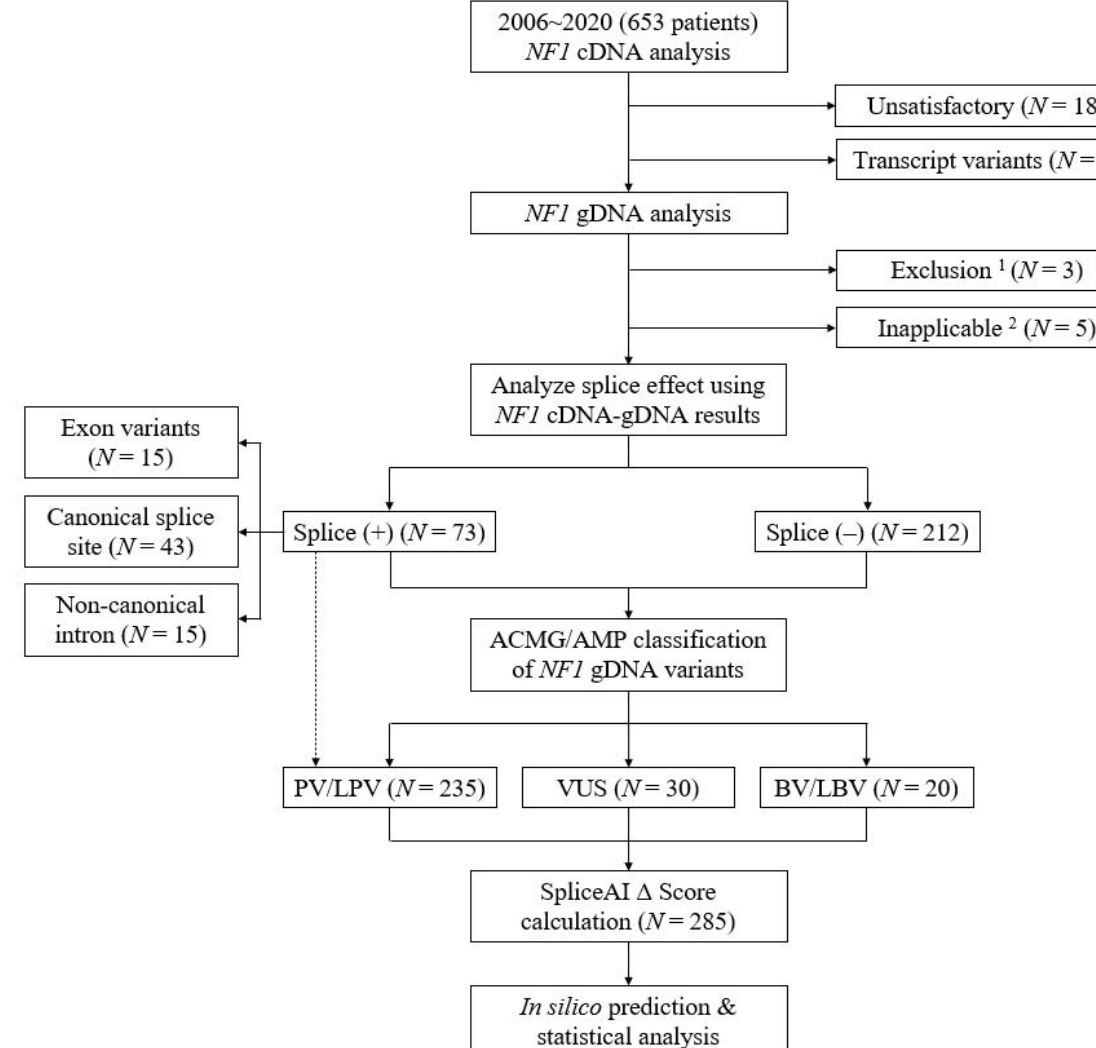
Figure 3. Study workflow. 1 Genomic DNA analysis showed no relevant variants. 2 Variants other than single nucleotide polymorphisms and simple insertions and/or deletions of bases. N denotes different types of NF1 variants. Abbreviations: cDNA, complementary DNA; gDNA, genomic DNA; ACMG, American College of Medical Genetics and Genomics; AMP, Association for Molecular Pathology; PV, pathogenic variant; LPV, likely pathogenic variant; VUS, variant of uncertain significance; BV, benign variant; LBV, likely benign variant.